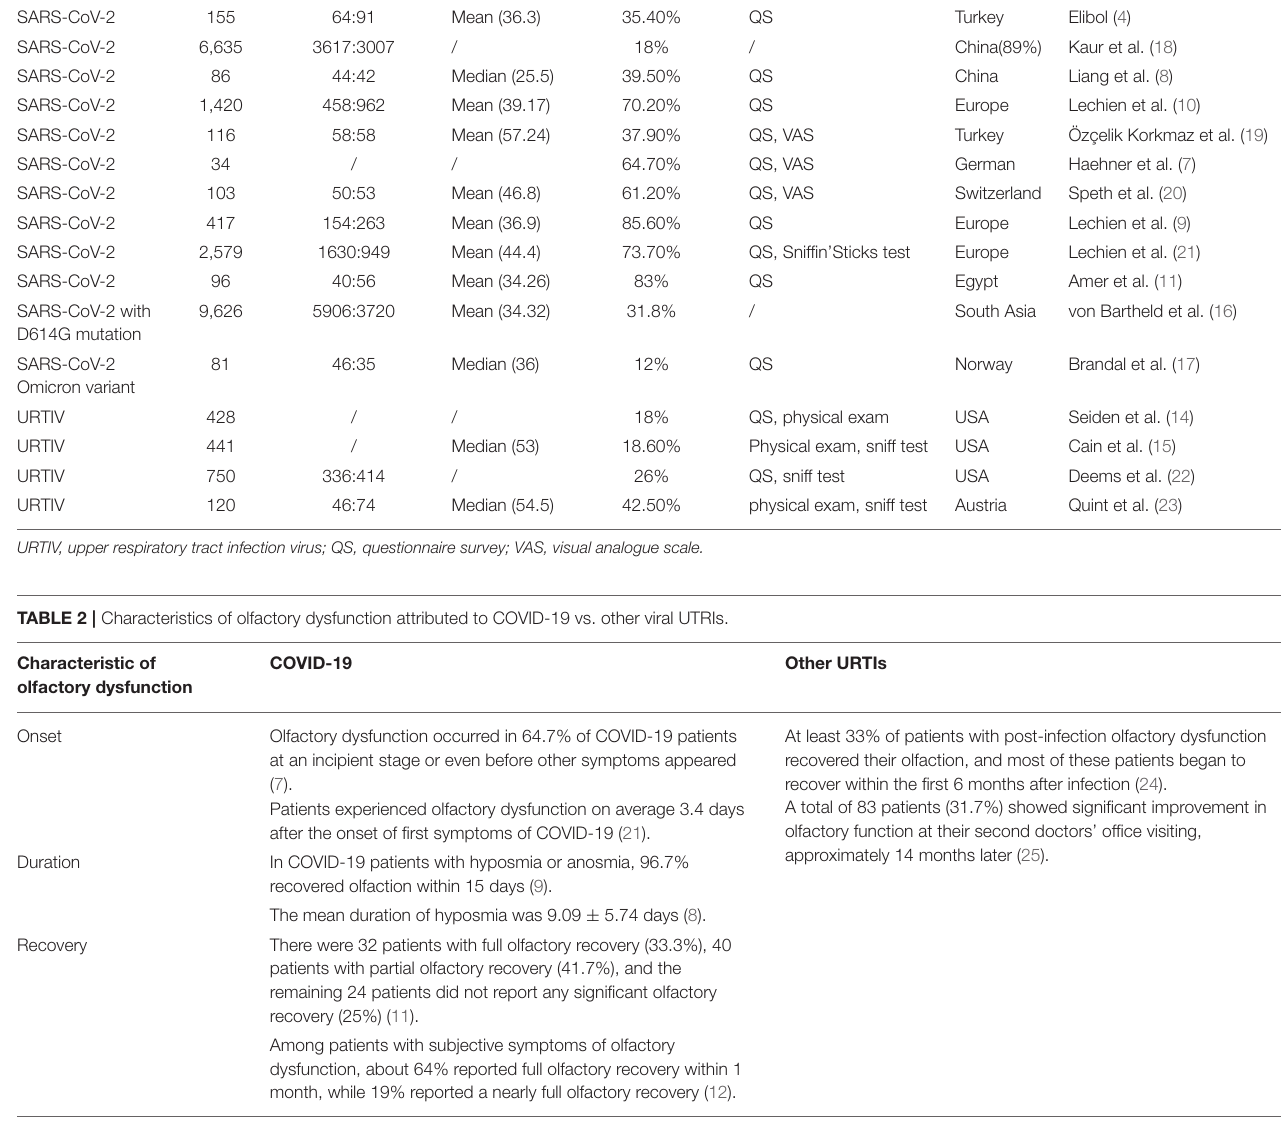
TABLE 1 | Incidence of olfactory dysfunction following infection with COVID-19 and its mutant strains and other upper respiratory viruses. Virus types Total no.